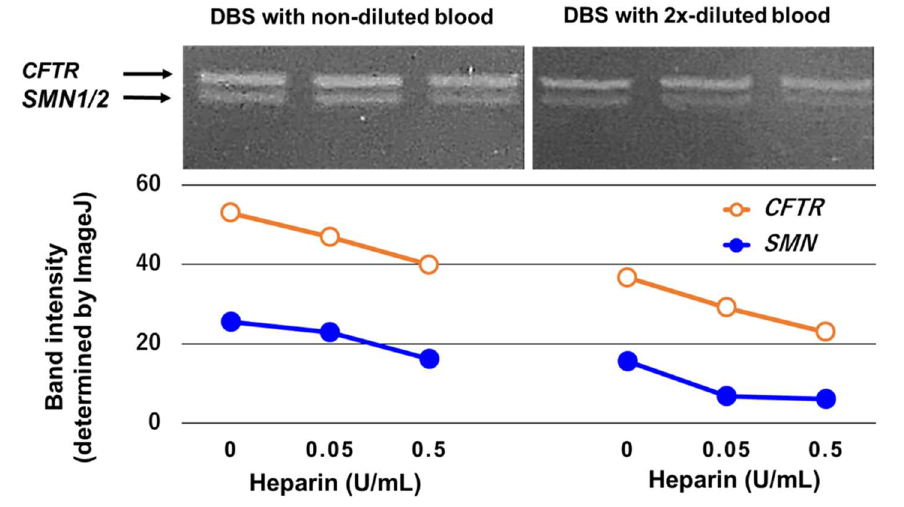
Figure 1. Influencing factors for PCR amplification. We tested the effects of white blood cell count, gene sequence, and heparin on the PCR amplification efficiency (Supplementary Tables S1–S5). In this experiment, we obtained three findings. First, the PCR product amounts of two-times diluted samples (half of the normal blood cell count) were less than those of non-diluted samples (normal blood cell count). Second, the PCR product amounts of SMN were much smaller than those of CFTR (a non- SMN gene). Third, the PCR product amounts of SMN and CFTR decreased in the presence of heparin. The decrease was in a heparin dose-dependent manner. SMN : survival motor neuron. CFTR : cystic fibrosis transmembrane conductance